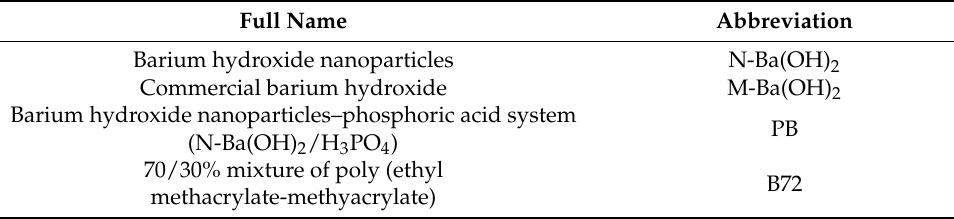
Table 1. Full names and abbreviations of the